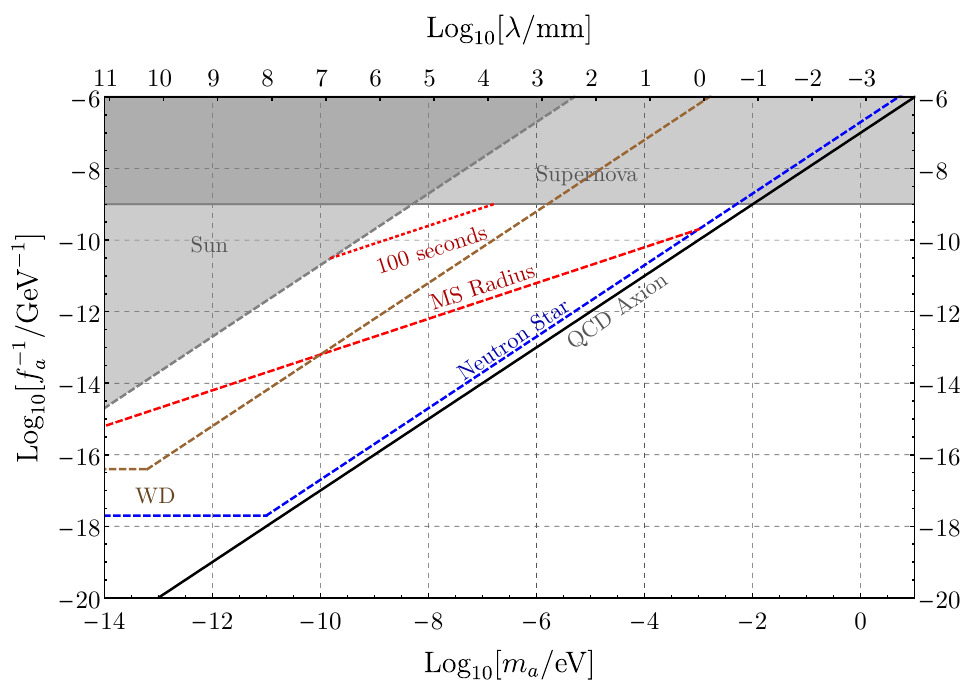
Figure 2 . Parameter space of light axions with matter couplings shown in section 2.1. Supernova constraints [51] and constraints coming from the measurement of solar neutrinos [31] are shown in shaded grey. Bubbles can be launched by a neutron star in the region to the left of the neutron star line (blue dashed). The bubbles will expand to roughly the size of a main sequence star at the lower red dashed line, and to a radius of 100 seconds at the upper red dashed